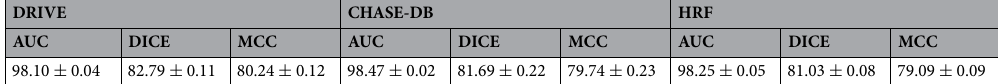
Table 3. Average performance of the Little W-Net model for each of the datasets in Table 2 over 5 training runs, with a confidence interval containing the true mean with probability p = 95% , under a normality assumption of the